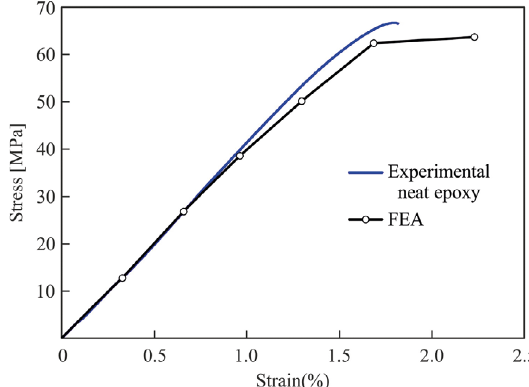
Figure 10. Comparison of experimental and predicted stress-strain